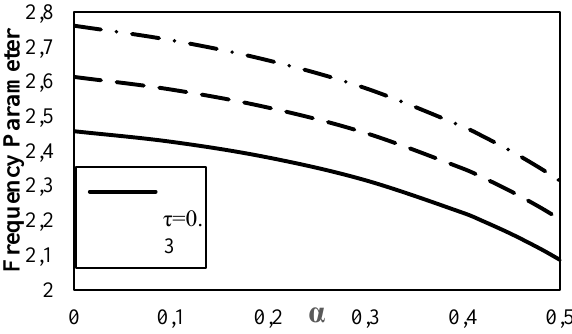
Figure 15: Dimensionless frequency vs. attached mass ratio. ( L / h = 10 , V = 0.2 , K w = K p = 20 , ∆T = 20 ∘ , ∆H = 20 )